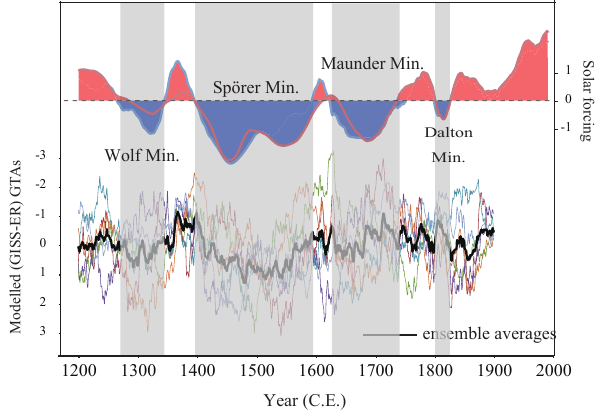
Fig. 7. Standardized solar variations (top panel) and GTAs [ G − NH ] in the GISS-ER simulations (bottom panel). The solar variations Figure 7. and shaded areas are the same as in Fig. 3. Thin lines in the GTAs [ G − NH ] represent each individual run, and the thick black line is the ensemble averages. Note that the y-axes for the GTAs [ G − NH ] are